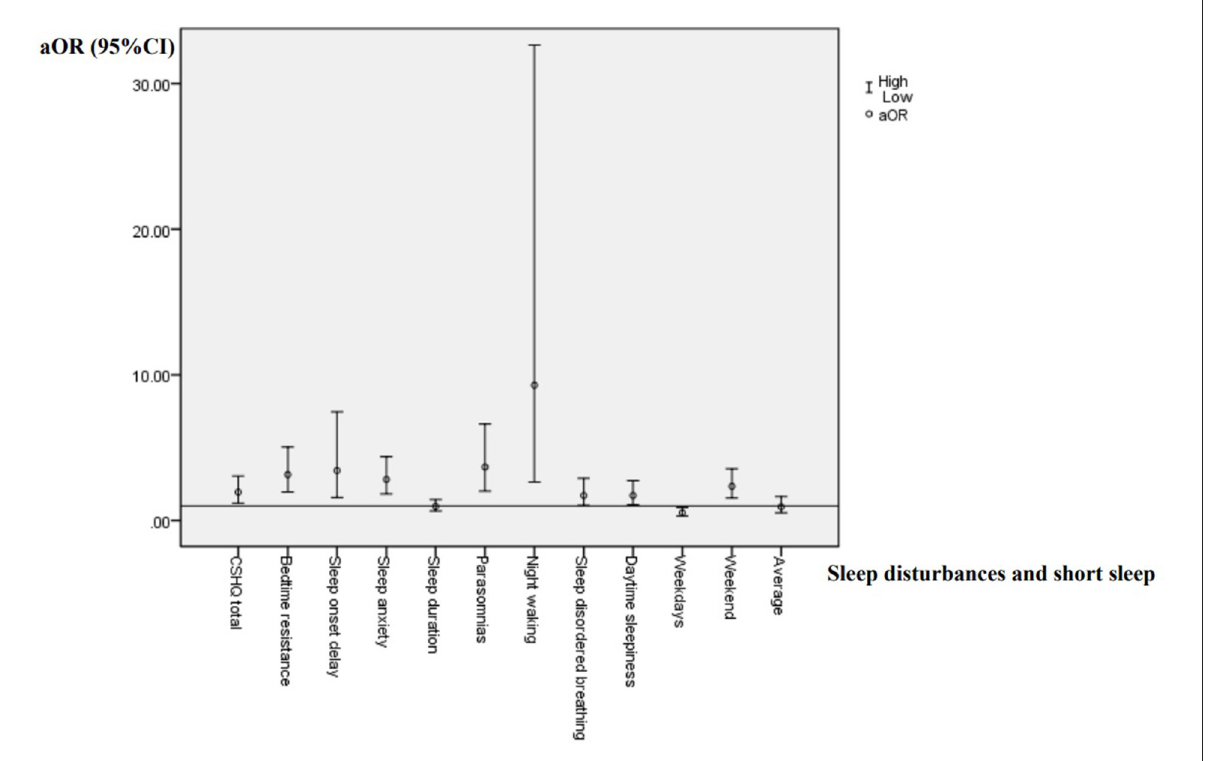
FIGURE1 The association of TD with sleep disturbances and short